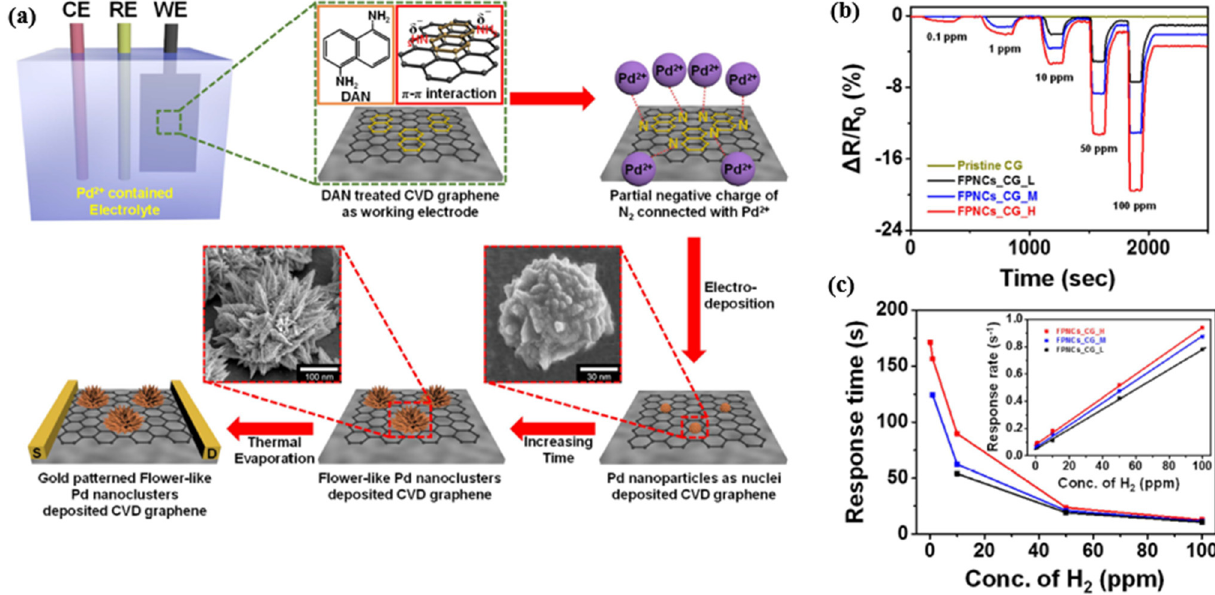
Figure 41. ( a ) Illustrative diagram for the fabrication steps of flower-like Pd nanoclusters (FPNCs) on chemical vapour deposition (CVD) graphene electrode. ( b ) Normalized resistance changes upon sequential exposure to H 2 gas of various concentrations (0.1 to 100 ppm) at room temperature, and ( c ) response time and rate (inset) vary with H 2 concentration [179]. Copyright (2015), with permission from Nature Publisher Group .